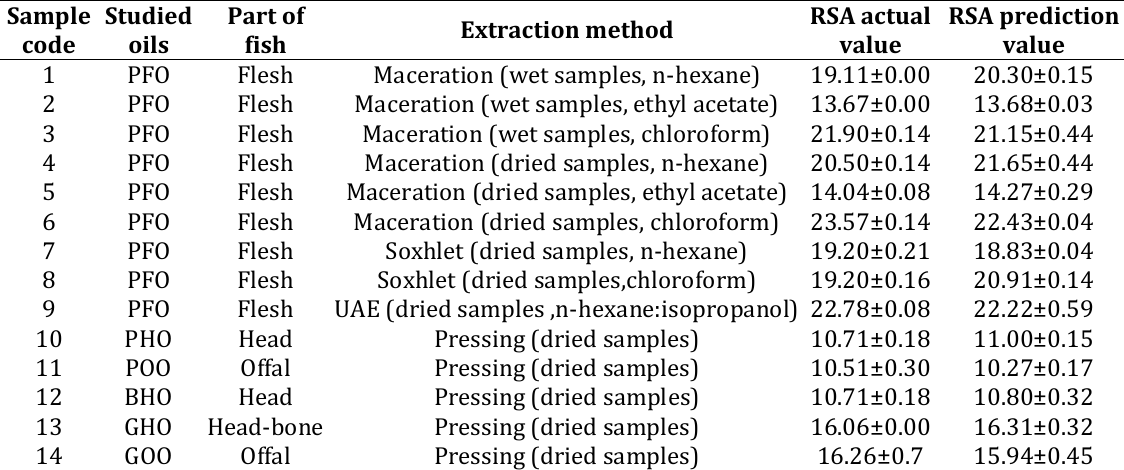
Figure 1. The PCA score plot of fish oil samples from different species and extraction methods. 1 = PFO by Maceration (n-hexane, wet samples); 2 = PFO by Maceration (ethyl acetate, wet samples); 3 = PFO by Maceration (chloroform, wet samples); 4 = PFO by Maceration (n-hexane, dried samples); 5 = PFO by Maceration (ethyl acetate, dried samples); 6 = PFO by Maceration (chloroform, dried samples); 7 = PFO by Soxhlet (n-hexane, dried samples); 8 = PFO by Soxhlet (chloroform, dried samples); 9 = PFO by UAE (n- hexane:isopropanol; dried samples); 10 = PHO by Pressing (dried samples); 11 = POO by Pressing (dried samples); 12 = BHO by Pressing (dried samples); 13 = GHO by Pressing (dried samples); 14 = GOO byPressing (dried samples). PFO = Patin flesh oil; PHO = Patin Head Oil; BHO = Bandeng Head oil; GHO = Gabus Head Oil; GOO = GabusOffal oil. Table I. Antioxidant activitiy of fish oil from different species and extraction